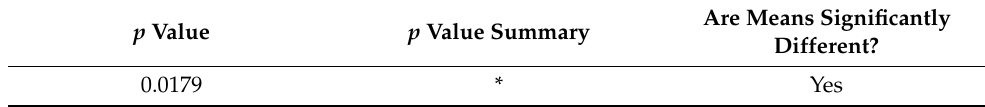
Table 5. Non parametric one way Anova among movement scores of P. lividus post-larvae feeding on Control Diet, diet A ( U. rigida, SHG ® microperle, Algamac Enrich) and diet B ( U. rigida , 2% spirulina SHG ® ). Threshold p < 0.05 (* = statistically